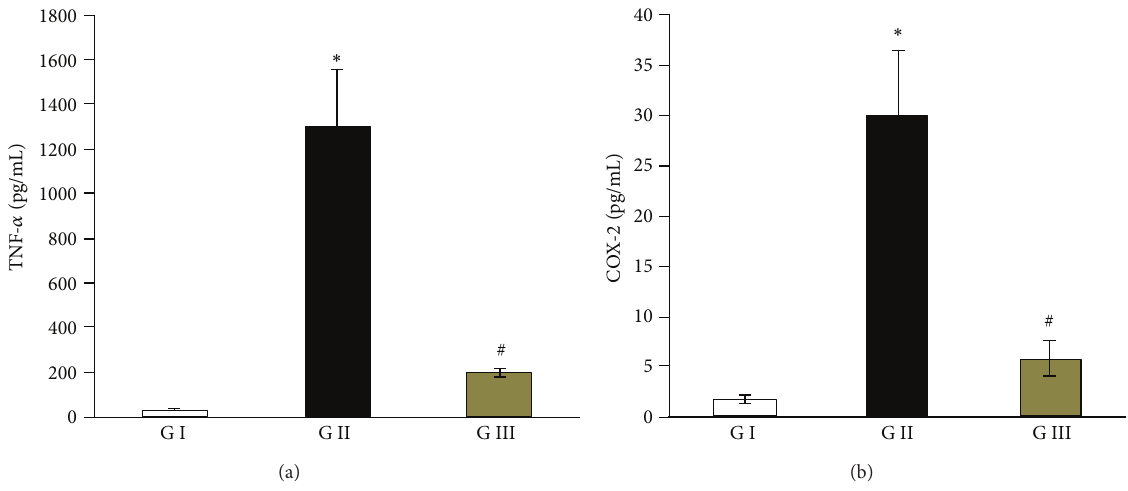
Figure 3: Levels of proinflammatory mediators; tumor necrosis factor- 𝛼 (TNF- 𝛼 ), and cyclooxygenase-2 (COX-2), in the liver tissues. GI: control group, GII: D-GalN/LPS group, and GIII: D-GalN/LPS + IL-22 group. Values are represented as mean ± SD. ∗ 𝑃 < 0.05 versus control group; # 𝑃 < 0.05 versus D-GalN/LPS untreated